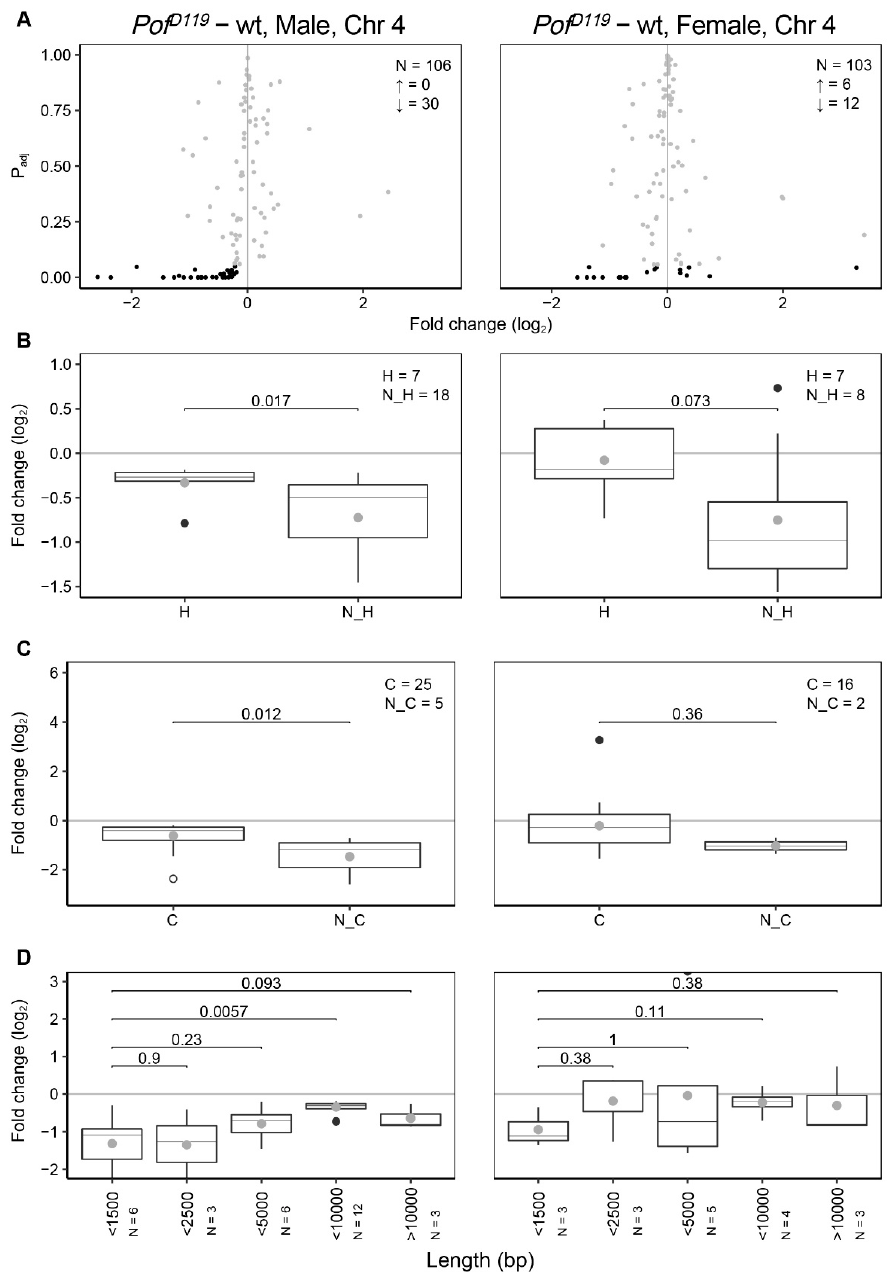
Figure 2. Feature analysis of significant differentially expressed genes on chromosome 4. ( A ) Differentially expressed genes on the 4th chromosome. N indicates the number of all altered genes, ↑ indicates the number of significant upregulated genes and ↓ indicates the number of significant downregulated genes. The grey dots refer to non-significant changes ( P adj > 0.05) and black dots indicate significant changes ( P adj < 0.05). ( B ) Comparison of expression ratios of housekeeping (H) and non-housekeeping (N_H) genes. ( C ) Comparison of expression ratios of coding (C) and non-coding genes (N_C). ( D ) Comparison of expression ratios of genes binned according to transcript length (bp) in which the binned transcript lengths represent the ranges 0–1500, 1500–2500, 2500–5000, 5000–10,000, and >10,000 bp, respectively. Only significant altered genes ( P adj < 0.05) were included in B–D. The box plots display median (line), average (dot), first and third quartiles (box), highest/lowest values within 1.5 × interquartile range (whiskers), and outliers. The statistical significance was determined by the Wilcoxon signed-rank test and p-values are